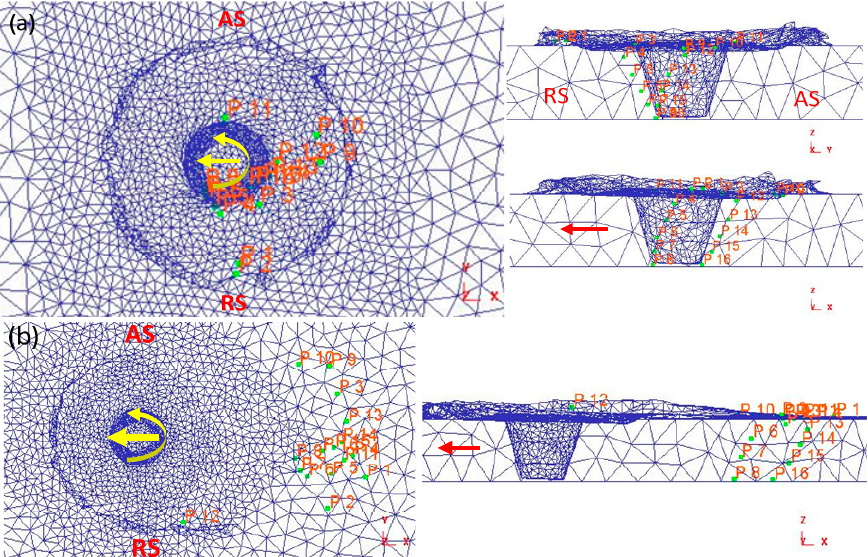
Figure 17. Material flow on the retreating side. ( a ) The tool is pressed down onto the given amount; and ( b ) the particles are deposited behind the tool.